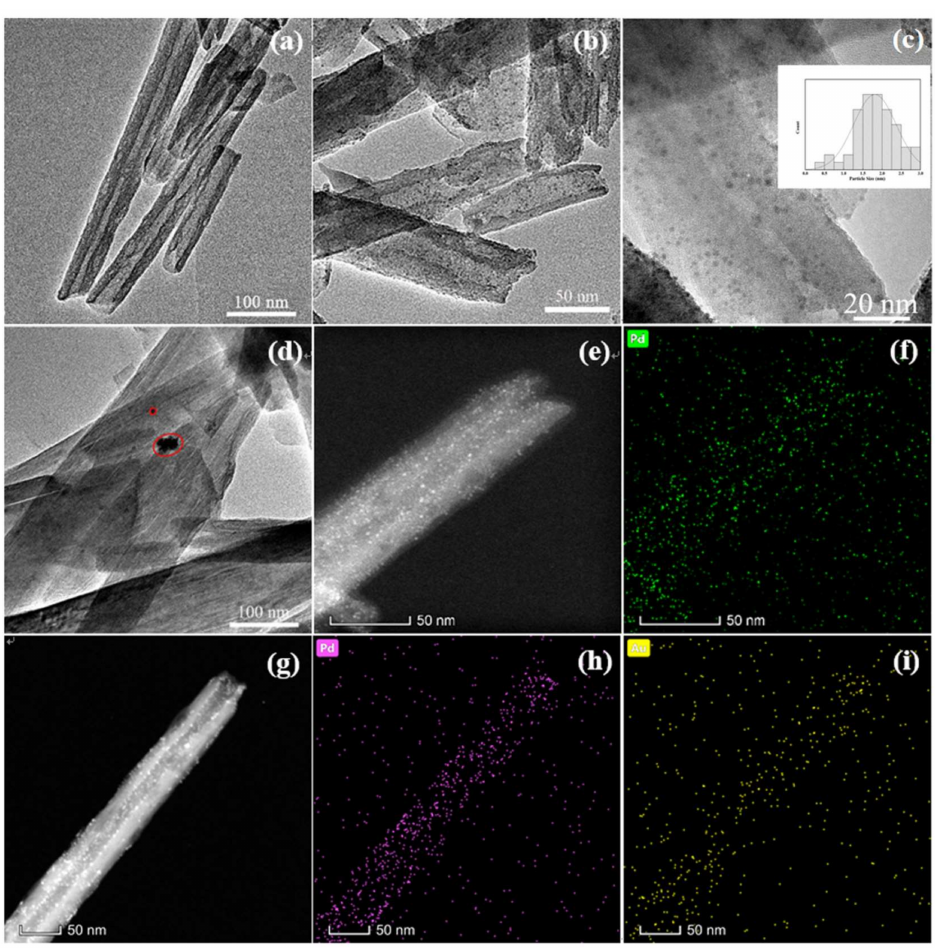
Figure 3. TEM images of ( a ) NH 2 -HNTs, ( b , c ) Pd/NH 2 -HNTs and ( d ) Pd/HNTs; ( e ) HAADF-STEM images of Pd/NH 2 -HNTs; ( f ) EDX mapping of Pd in Pd/NH 2 -HNTs; ( g ) HAADF-STEM images of PdAu/NH 2 -HNTs; ( h ) EDX mapping of Pd in PdAu/NH 2 -HNTs; ( i ) EDX mapping of Au in PdAu/NH 2